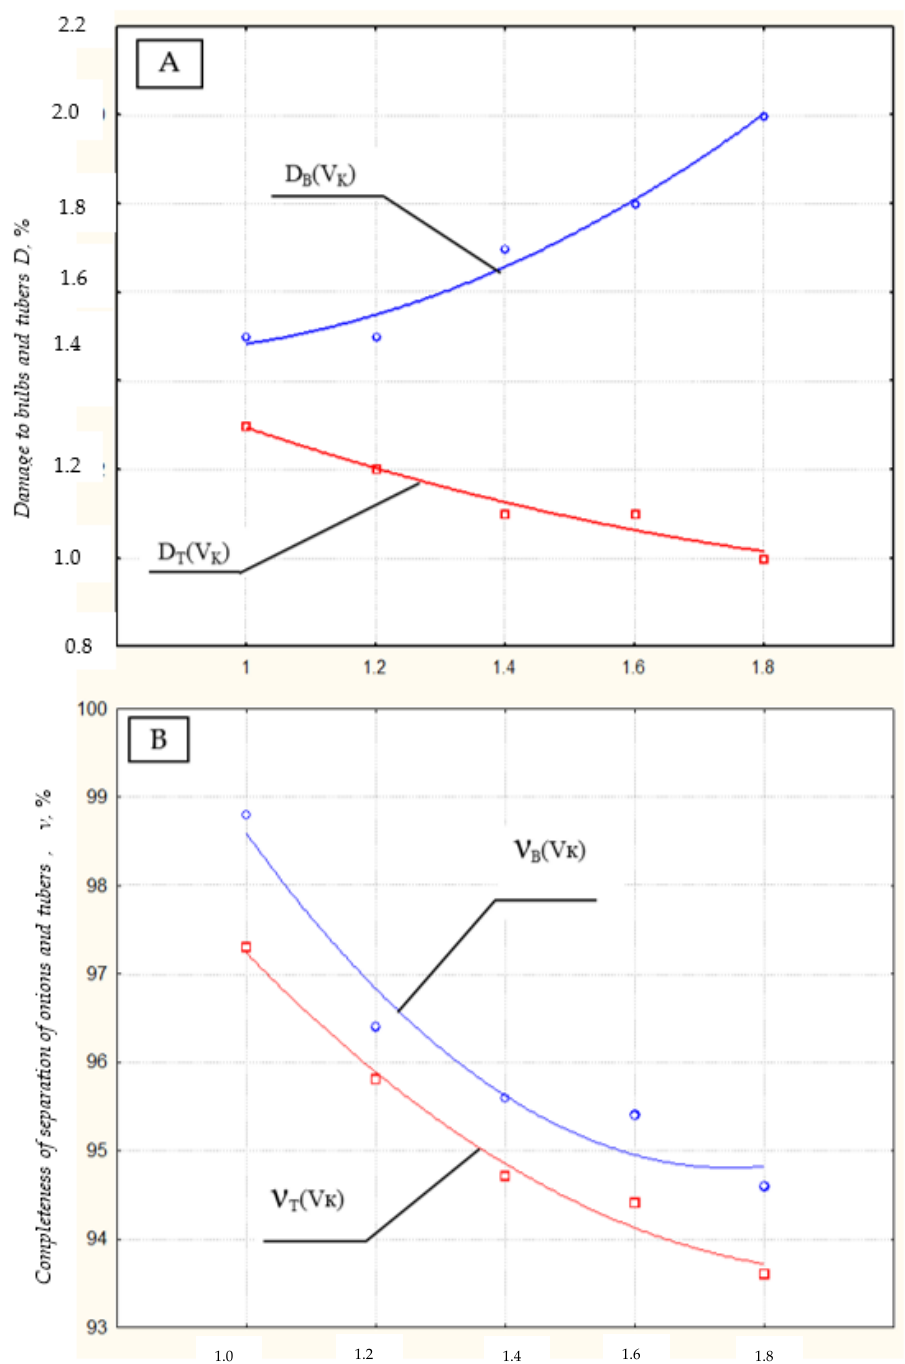
Figure 9. Dependence of: ( A ) damage to bulbs D L and tubers D K %; and ( B ) completeness of separation of onions ν B and tubers ν T % of the separating rod elevator with an adjustable blade inclination angle from the forward speed v K of the